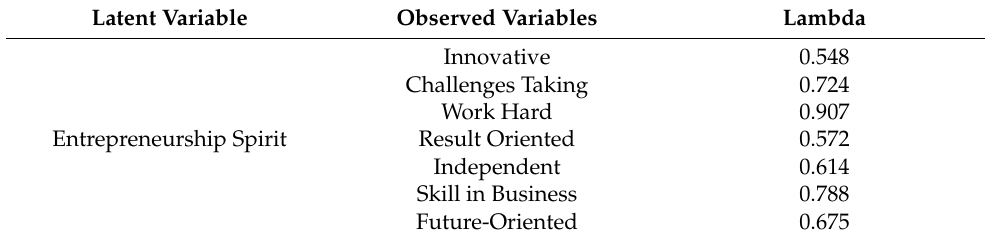
Table 5. The measurement model of entrepreneurship spirit variable of students.